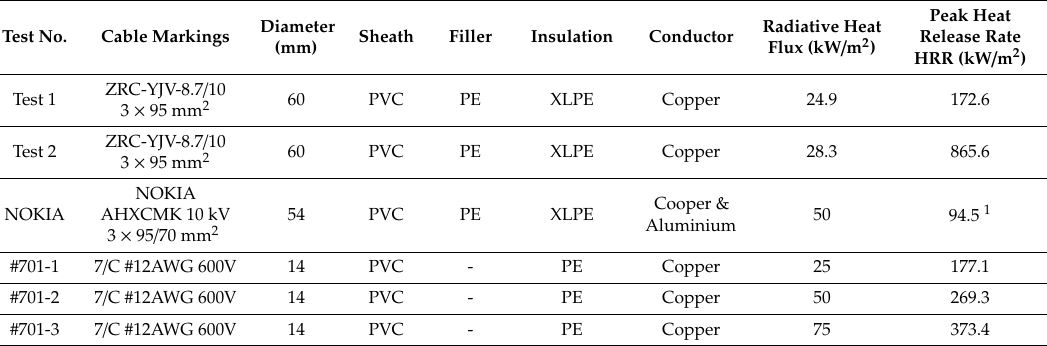
Table 2. Components of the three types of cables.